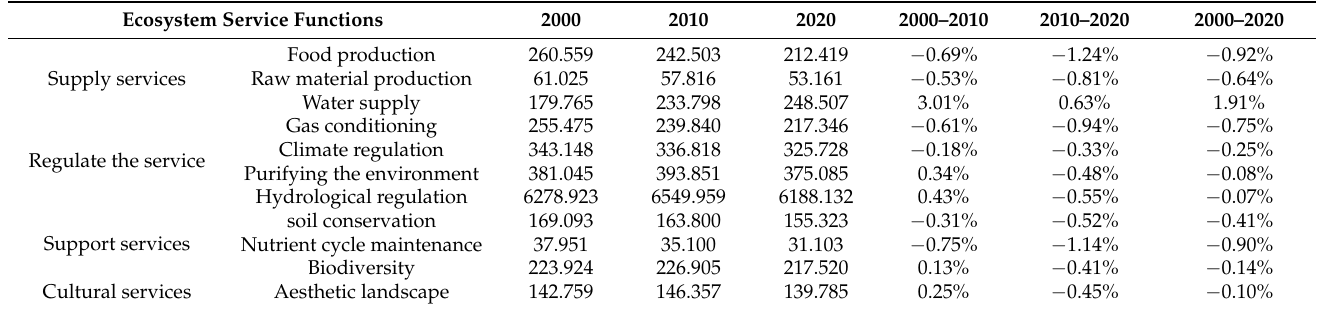
Table 5. Value of individual ecosystem services in southern Jiangsu from 2000 to 2020 [unit: CNY 100 million] and proportion of change [unit: